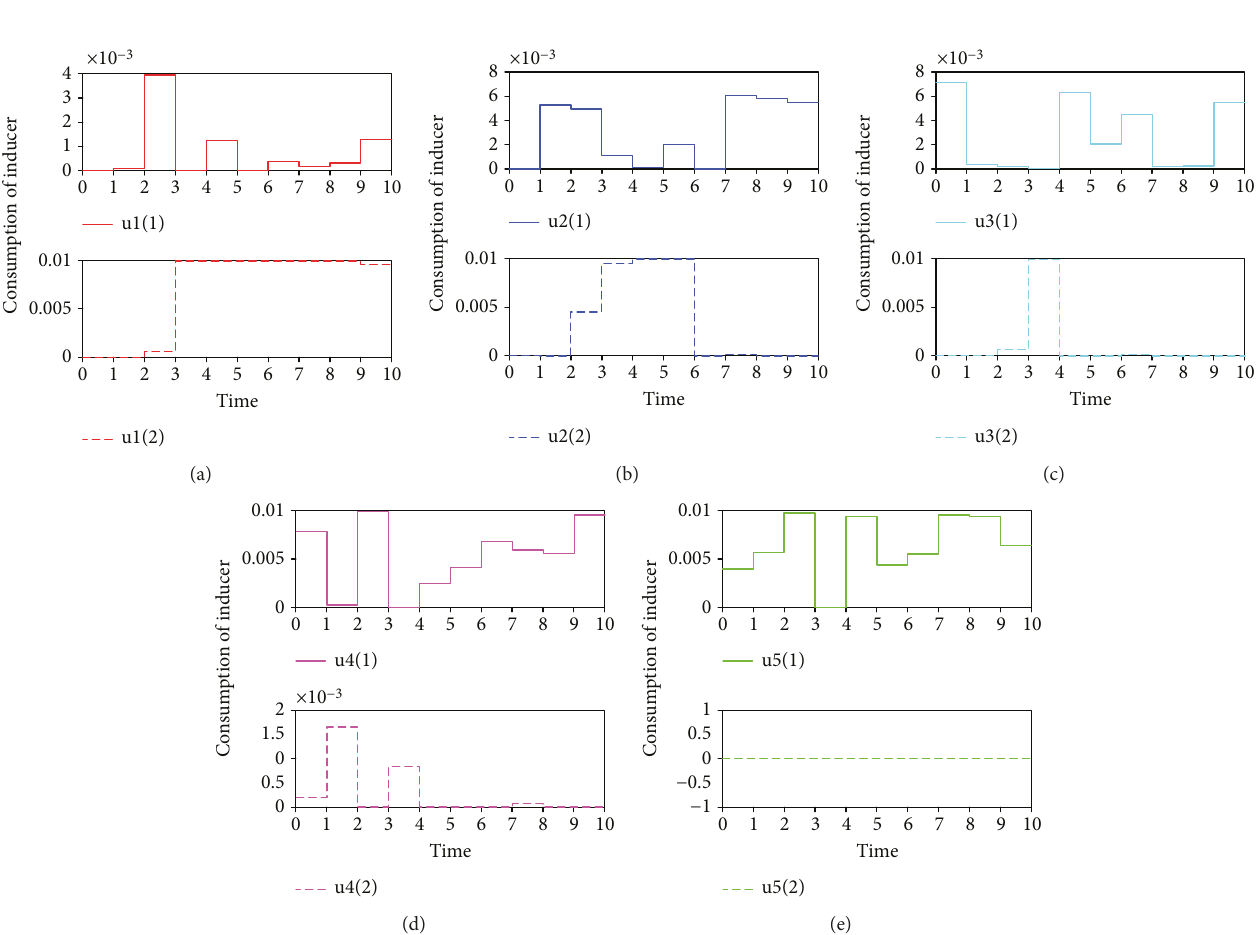
Figure 17: The Pareto optimal trajectories of fi ve selected solutions for case III. (a) u1, (b) u2, (c) u3, (d) u4, and (e)